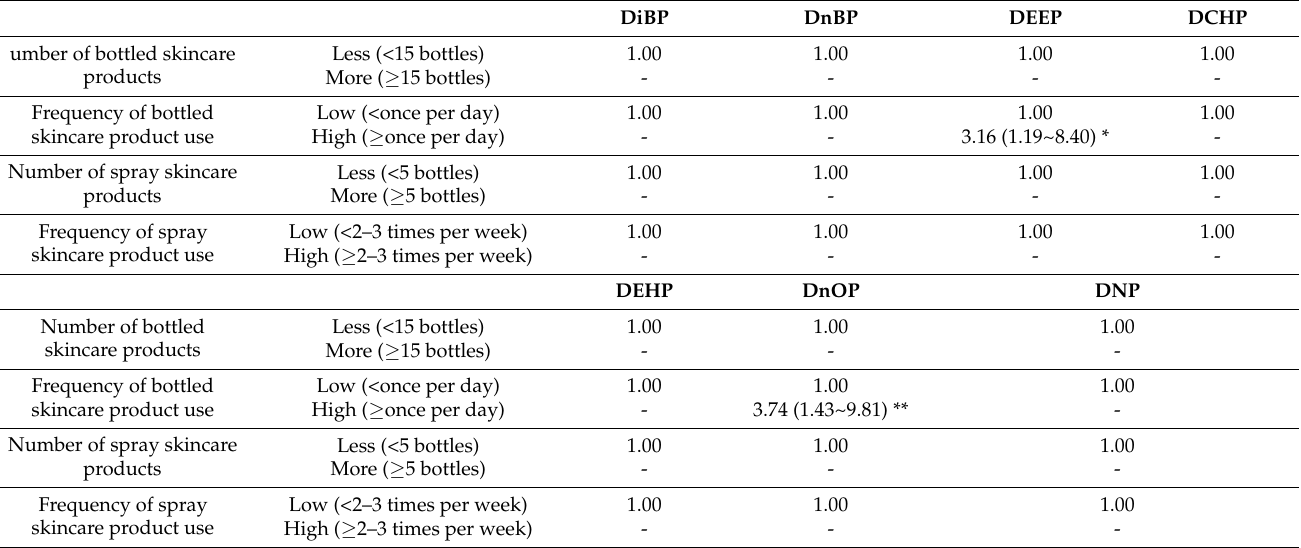
Table 5. Results of multivariate logistic regression analysis between personal care products and phthalate concentrations (95% confidence